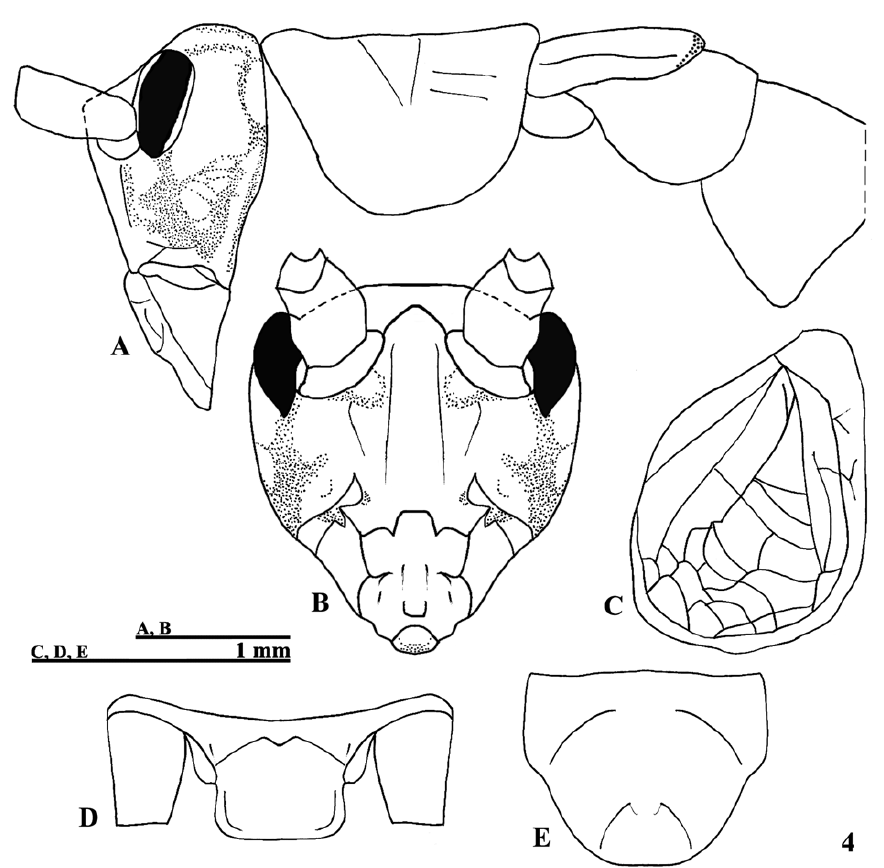
Fig. 4 – Male of Phalangopsis bauxitica sp. nov. A. Lateral view of the head and pronotum. B. Frontal view of the head. C. Dorsal view of the forewing. D. Supra-anal plate. E. Subgenital